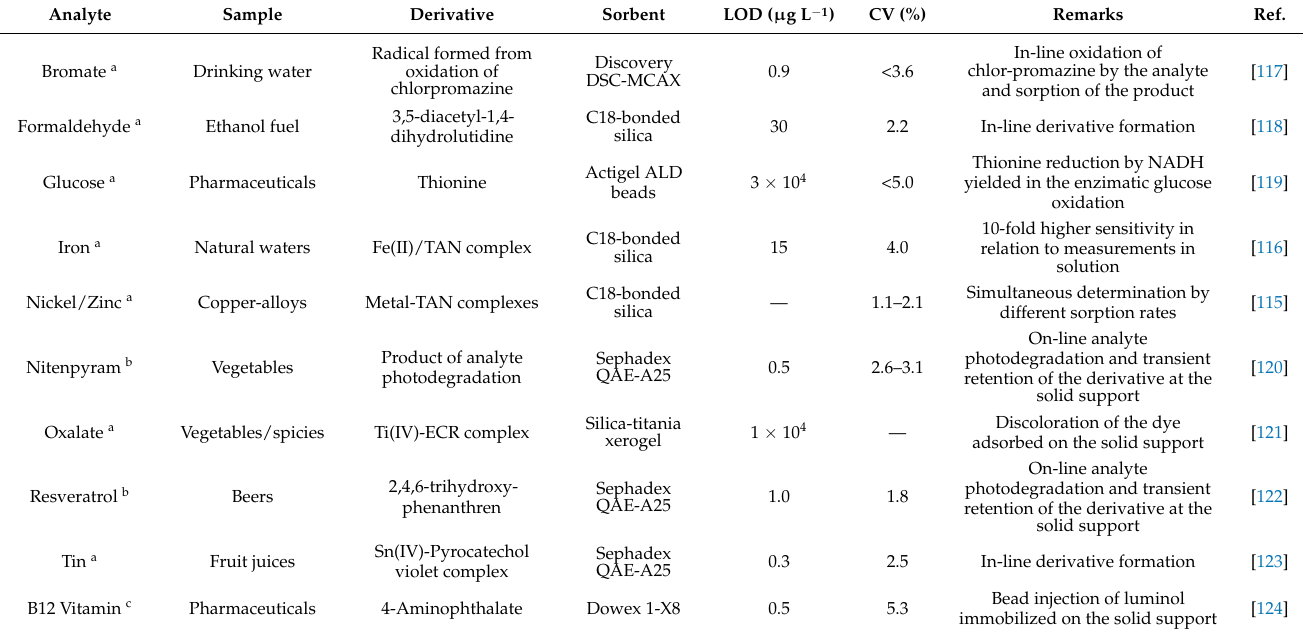
Table 3. Selected applications of flow-based optosensing involving chemical